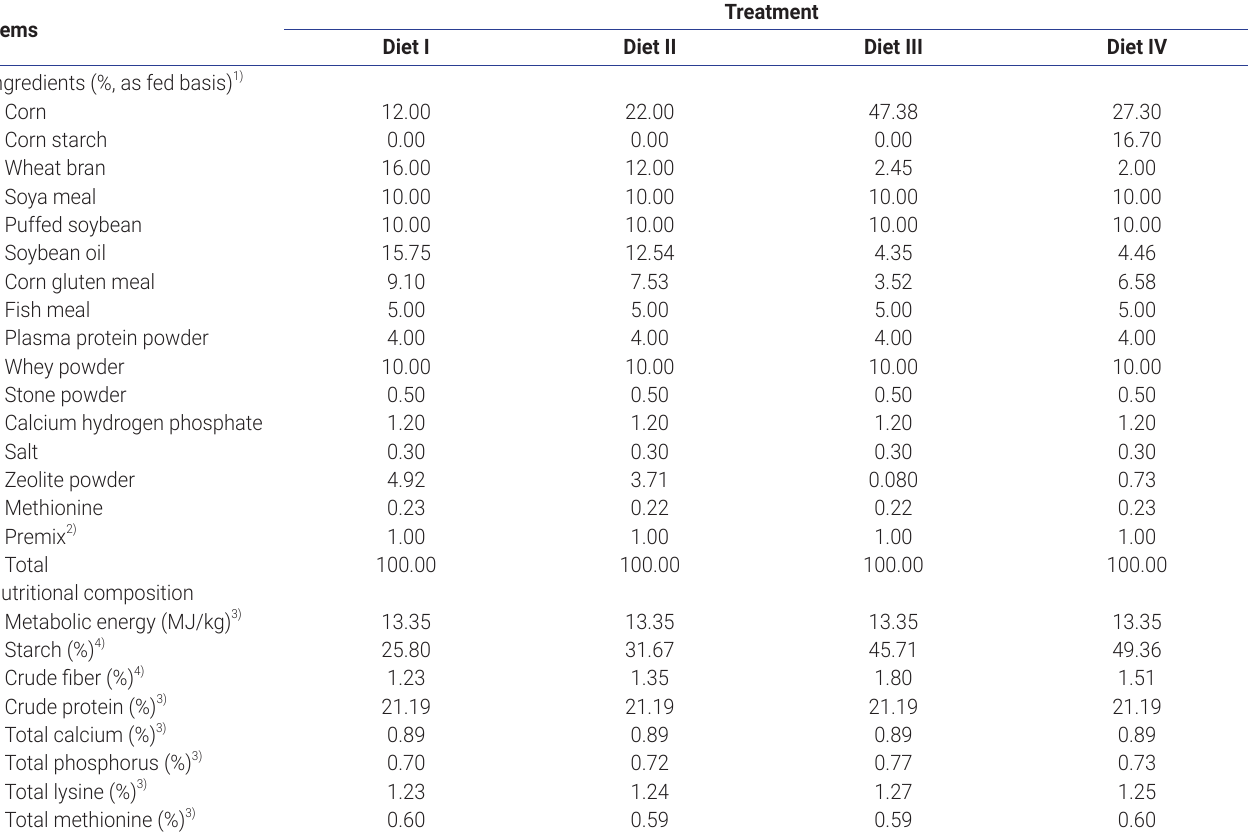
Table 1. Ingredients and nutritional composition of experimental diets in Exp 1